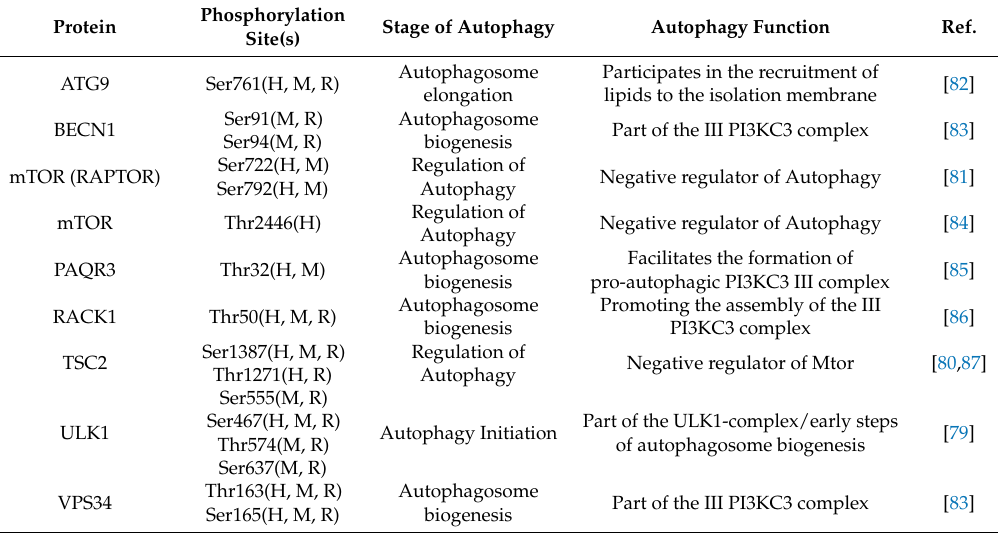
Table 1. Regulation of autophagy relevant proteins by AMPK. H, human; M, mouse; R, rat. Phosphorylation Protein Stage of Site(s)